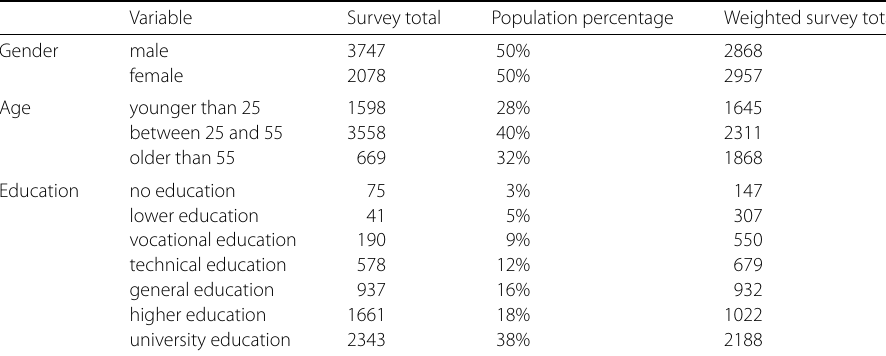
Table 5 Gender, age and education of the Belgian population [67] Variable Survey total Population percentage Weighted survey total